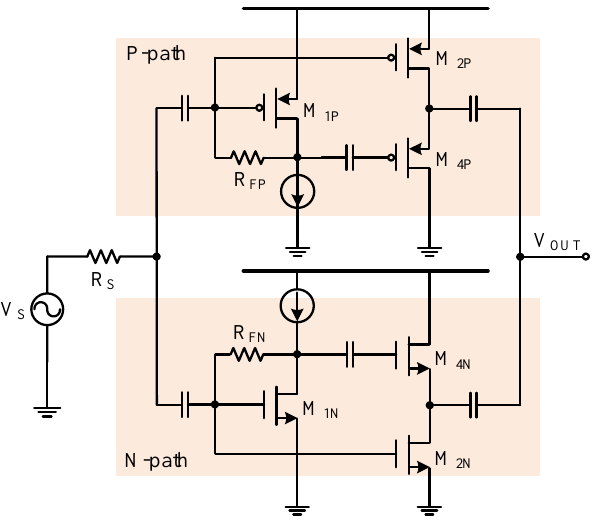
Figure 10. Proposed resistive shunt-feedback LNA with the feedforward noise-canceling technique and the complementary topology [17].